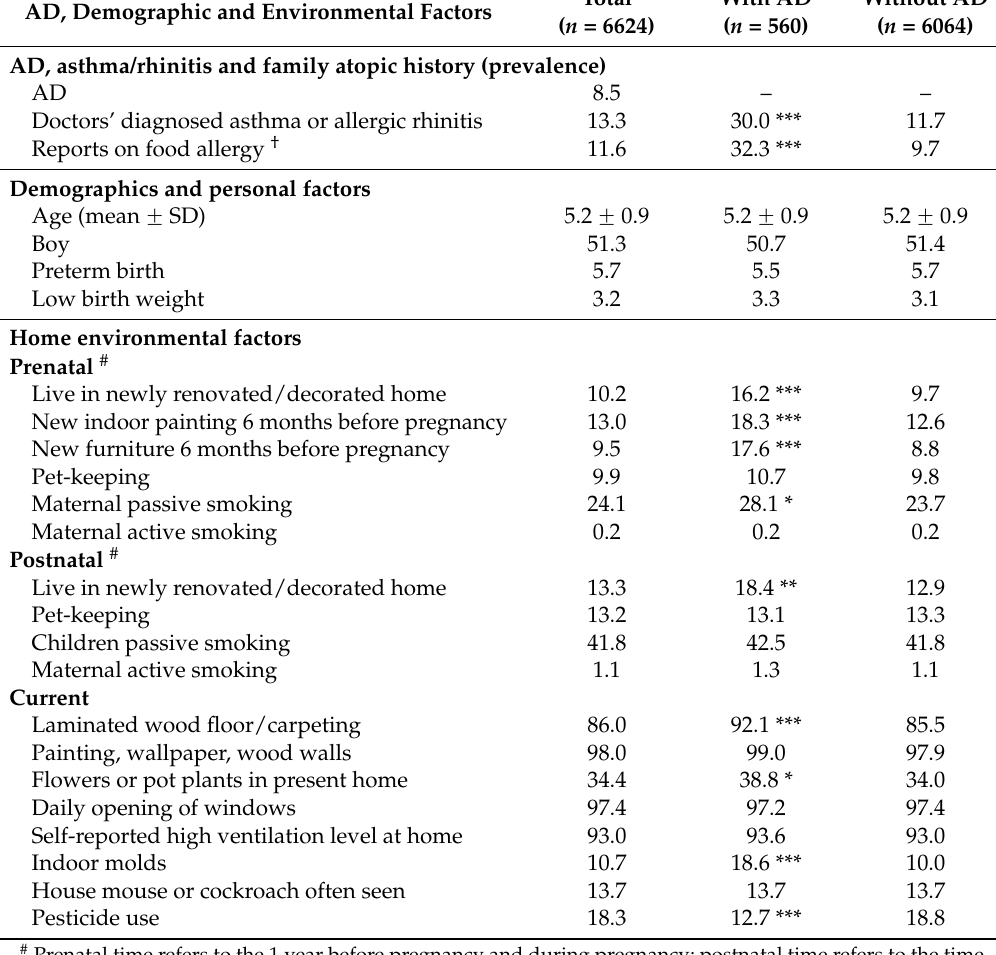
Table 1. Prevalence of AD and proportions of different factors in total subjects and in subjects with and without AD. AD, Demographic and Environmental Factors